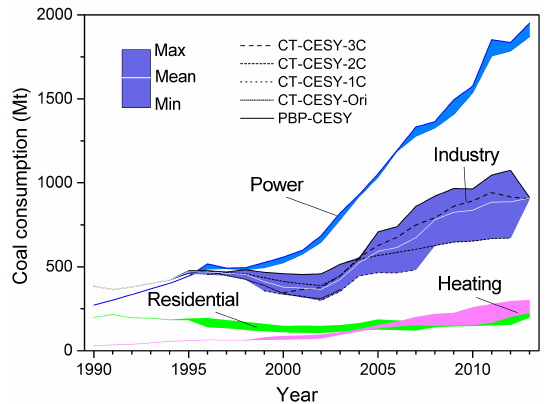
Figure 2. Apparent uncertainties (shown as filled areas) in China’s coal consumption from 1990 to 2013, by sector. Note that CT- CESY-Ori, CT-CESY-1C, CT-CESY-2C and CT-CESY-3C are shown for 1990–2003, 1999–2007, 1996–2012 and 2000–2013, re-